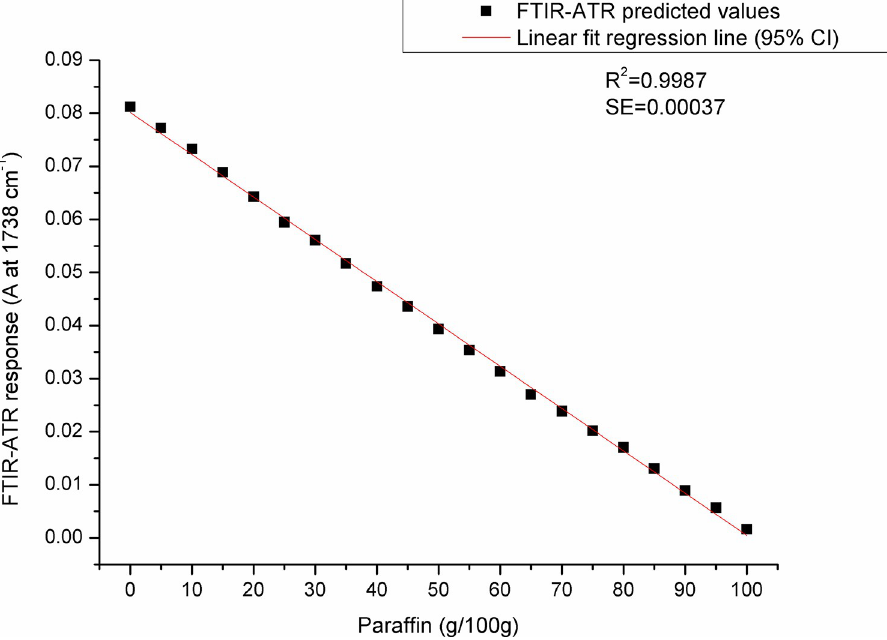
Fig 5. Prediction performance parameters of the calibration curve constructed for determination of the paraffin share in beeswax: A scatter plot of FTIR-ATR predicted values (instrument response) versus real (known) paraffin share values using the spectral region with an absorption maximum at 1738 cm -1 .